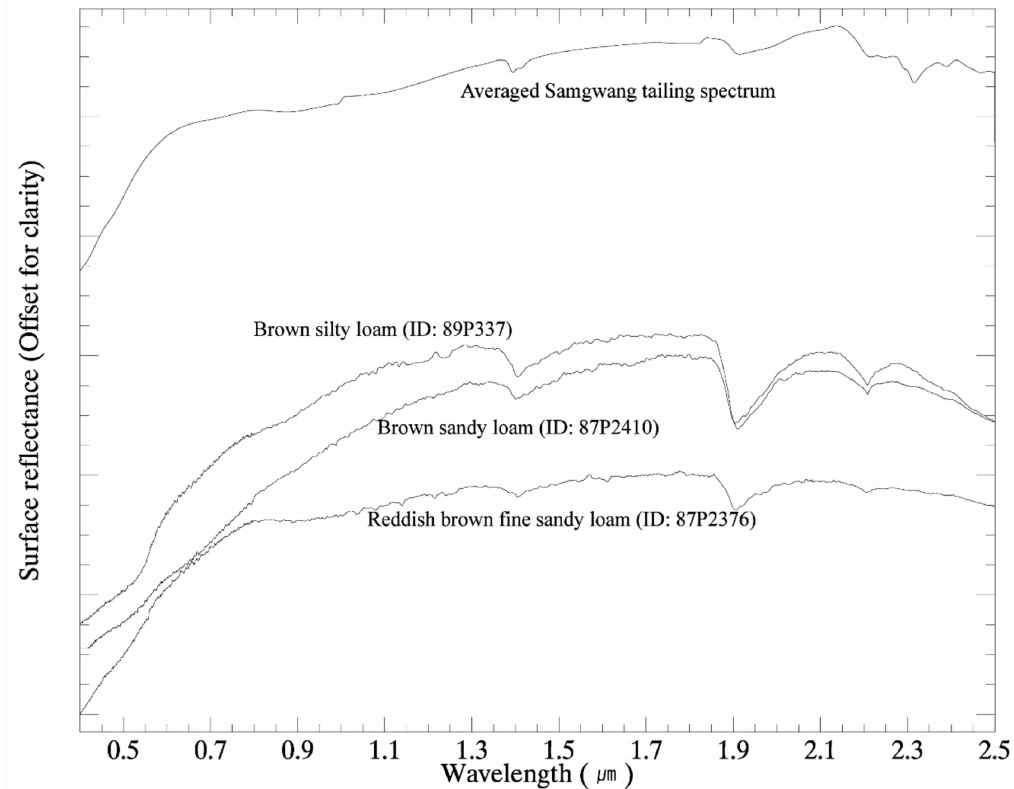
Figure 8. Comparison between the spectra of standard soil (from JPL spectral library) and Samgwang